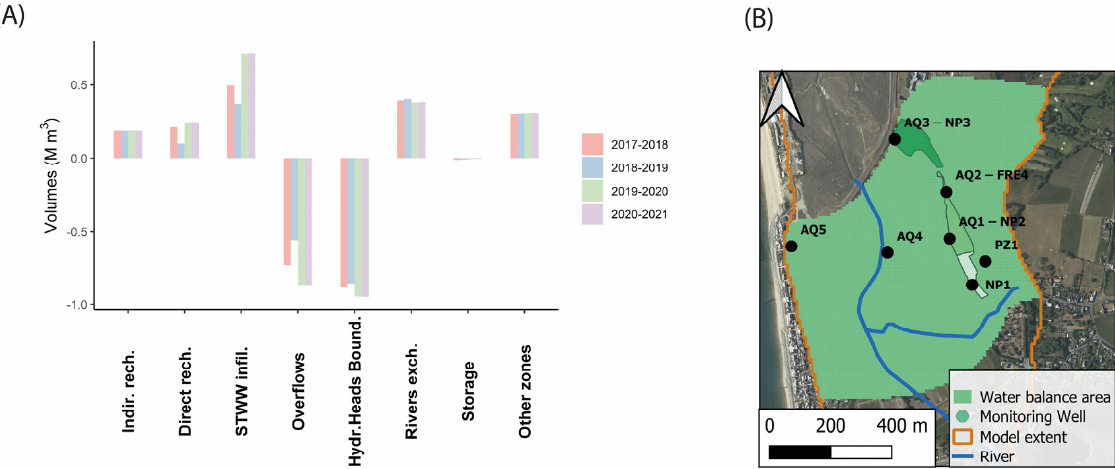
Figure 9. ( A ) Hydrodynamic balances by hydrogeologic year (e.g., 2017–2018: 1 October 2017–1 October 2018) on direct and indirect natural recharge, infiltrated STWW, overflow, fixed hydraulic heads at the western boundary of the model (marine conditions), aquifer/river exchanges, aquifer storage, and volumes from other zones (balance area is shown in ( B ). Negative values indicate water outflow from the aquifer and positive values indicate water inflow into the aquifer.